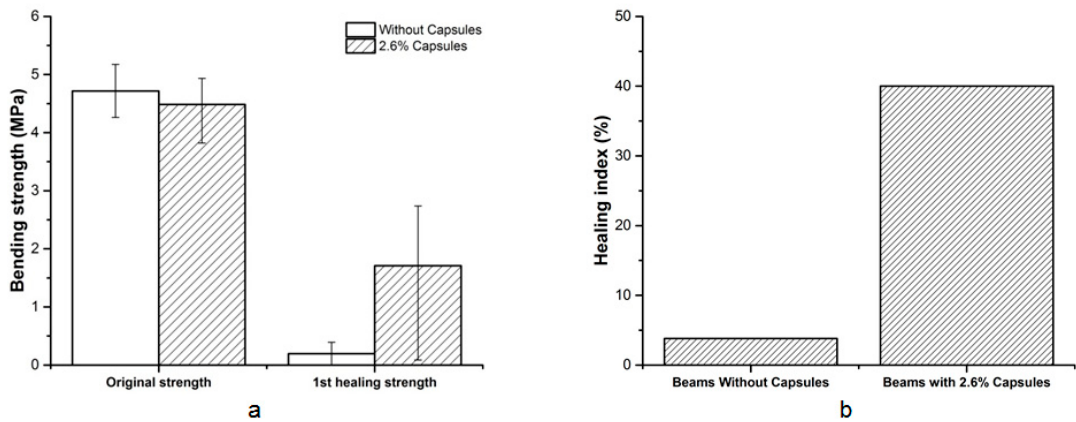
Figure 9. Testing of aged asphalt mortar beams in bending and healing program: ( a ) Bending strength and ( b ) healing efficiency.